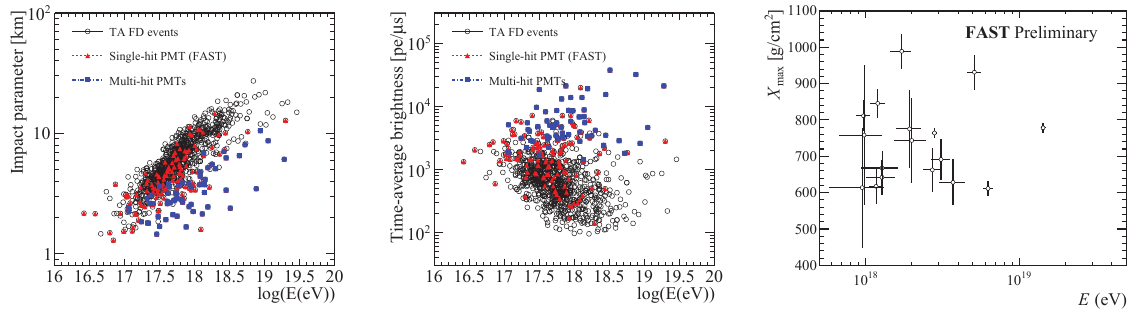
(a) FAST prototypes installed at TA (left) and Auger (right) observatories